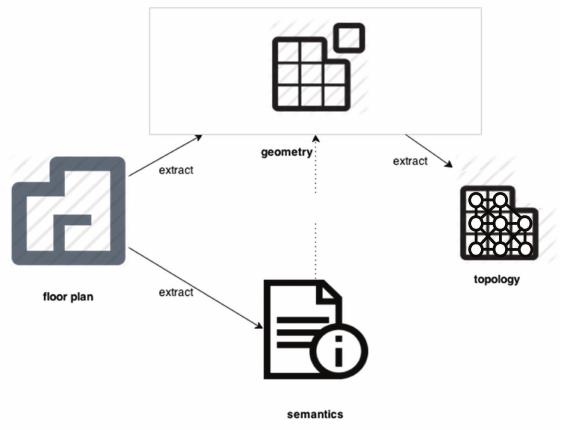
Figure 1: Spatial model